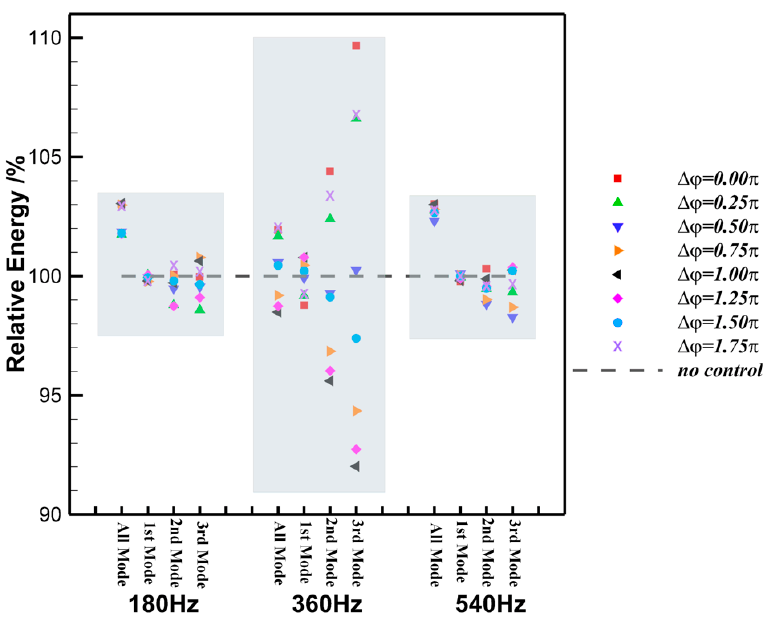
Figure 20. Comparison of modal energy under different control frequencies.